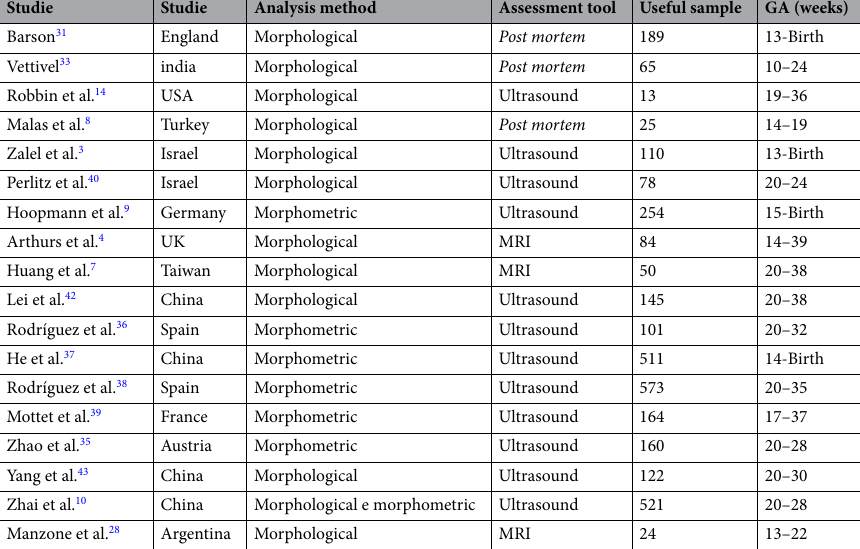
Table 2. Characteristics of studies included in present review. GA: Gestational age.